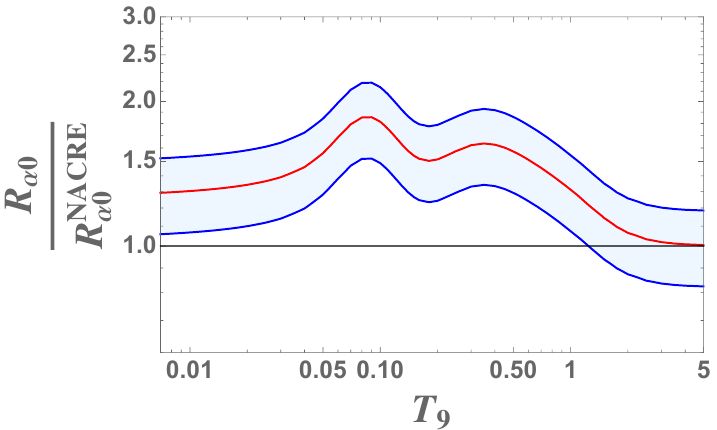
Figure 8. Ratio between the 19 F(p, α 0 ) 16 O THM reaction rate [109] and the NACRE recommended one [82] (red line). The estimated uncertainties on THM data are reported as a blue band. The black line corresponds to a ratio equal to